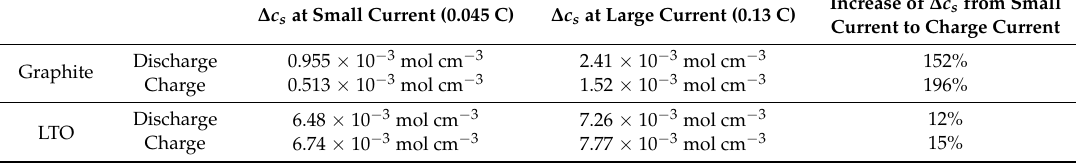
Table 5. Comparison of the difference in c s between the center and the surface of a solid particle in graphite and LTO half-cells at small and large current rates.